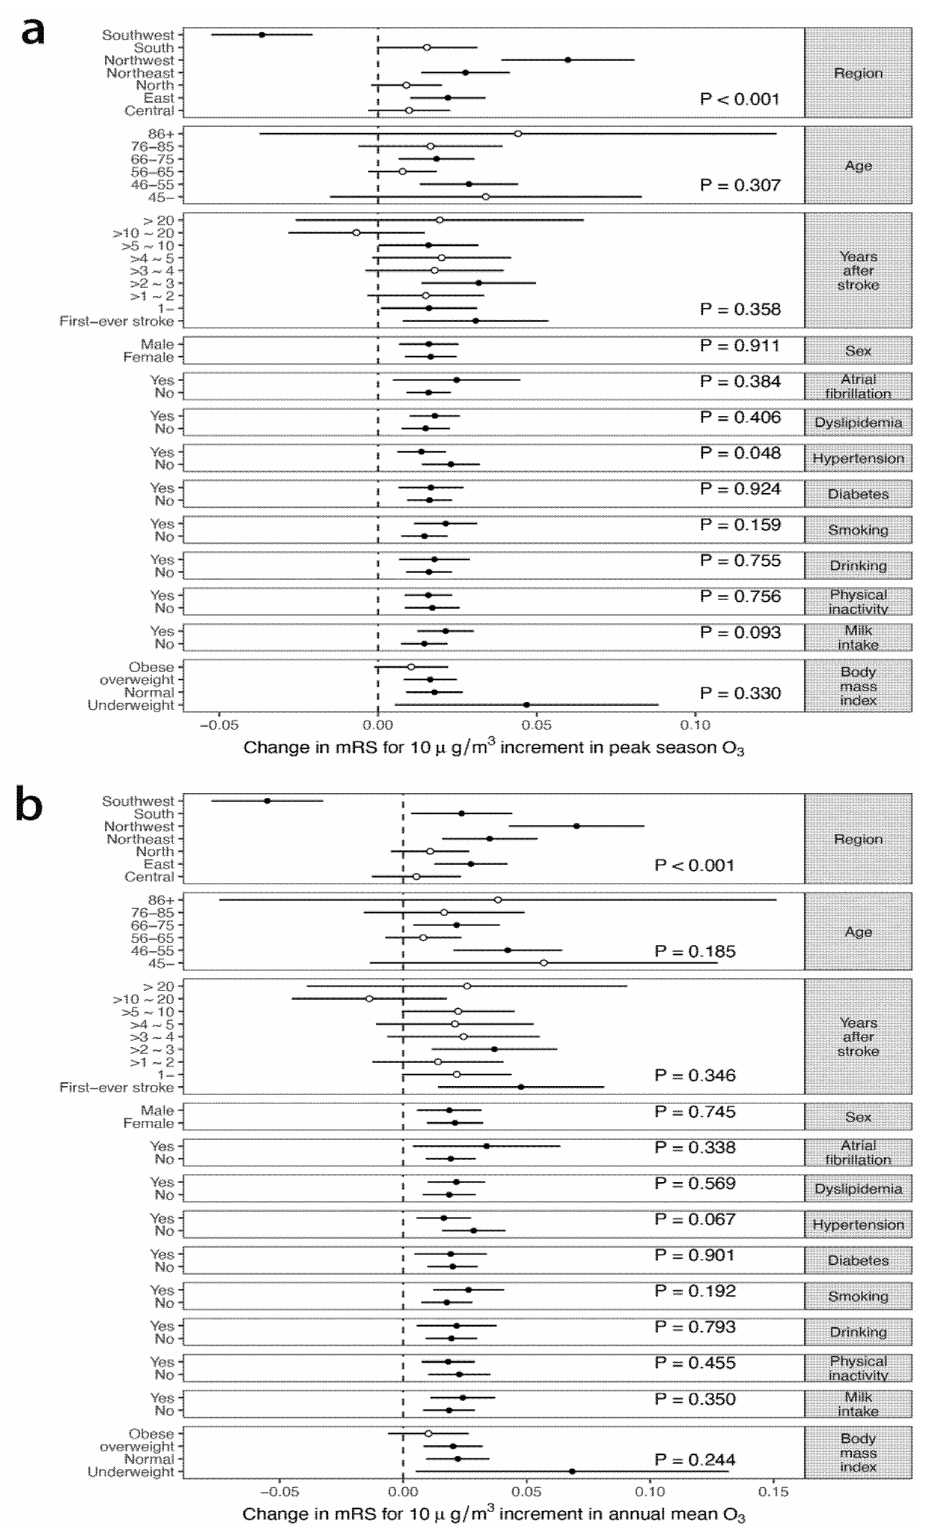
Figure 3. Subpopulation-specific effect of O 3 exposure with mRS score outcomes for per 10 ug/m 3 increment of O 3 by demographic subgroups. ( a ) Peak-season O 3 . ( b ) Annual mean O 3 . Models were adjusted for the interaction of the follow-up period with age at baseline, the interaction of the follow-up period with years after stroke at baseline, season of the study, smoking, drinking, physical activity, milk intake, body mass index, hypertension, diabetes, dyslipidemia, and atrial fibrillation. mRS, modified Rankin